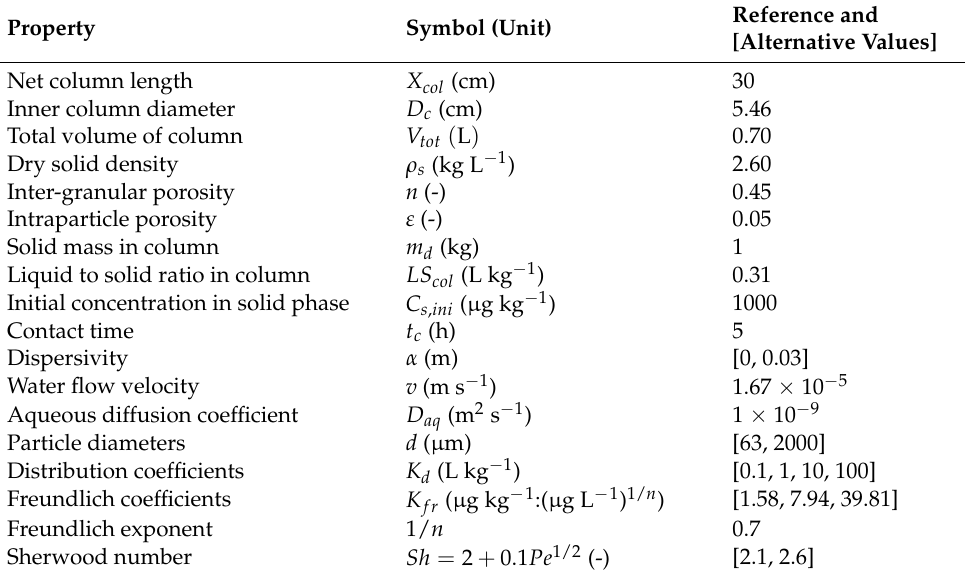
Table 1. Summary of parameter values and ranges used to set up the numerical